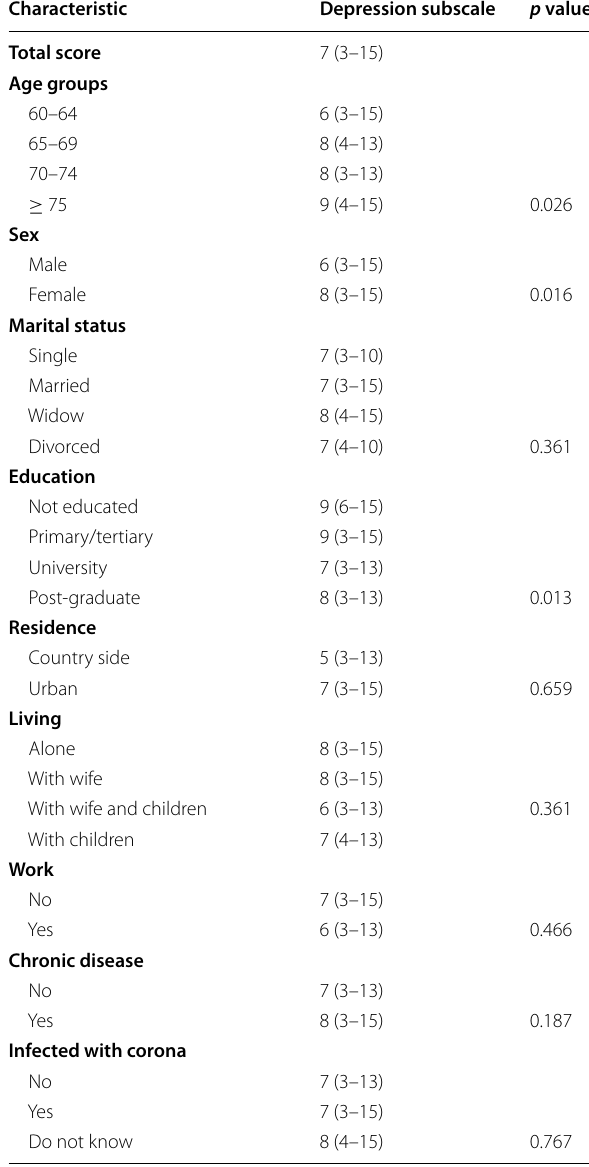
Table 4 Relation between depression subscale of HADS and socio-demographic factors